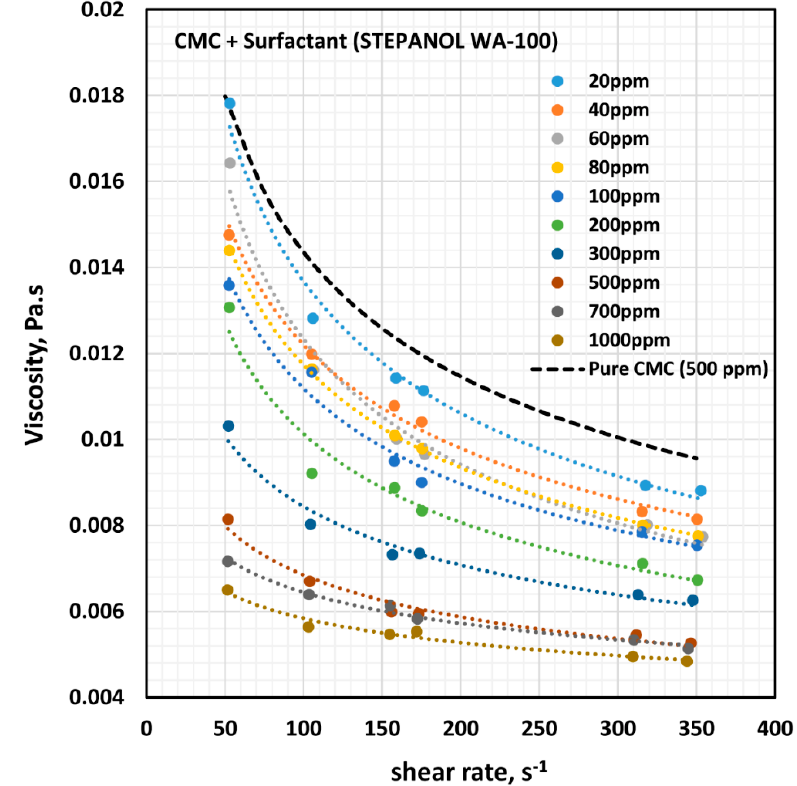
Figure 8. Effect of anionic surfactant (Stepanol WA-100) on the viscosity versus shear rate behavior of solutions of mixtures of anionic polymer, CMC, and anionic surfactant, Stepanol WA-100, at a fixed polymer concentration of 500 ppm.